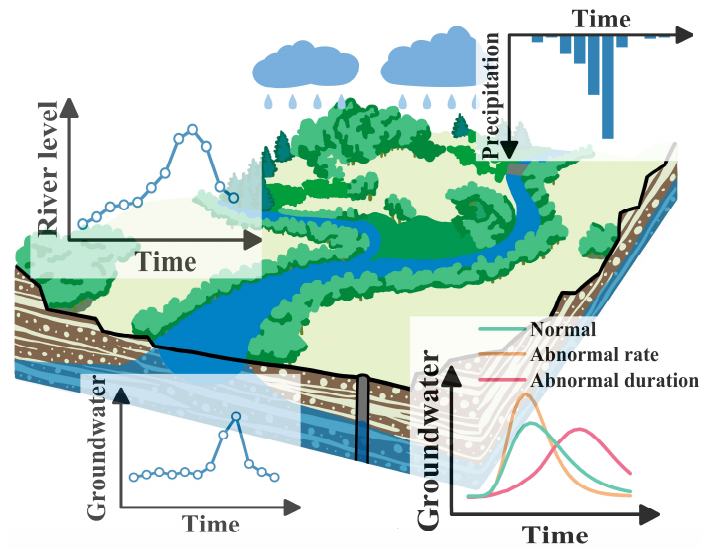
Figure 1. Conceptual model of abnormal groundwater level rising (AGLR).